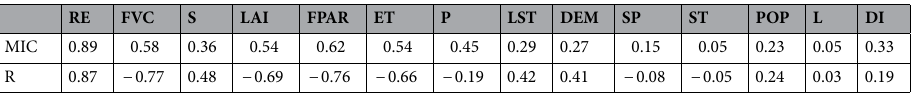
Table 1. MIC and correlation coefficients on the factors influencing of KRD. RE rock exposure, FVC fractional vegetation cover, S slope, LAI leaf area index, FPAR fraction of photosynthetically active radiation,